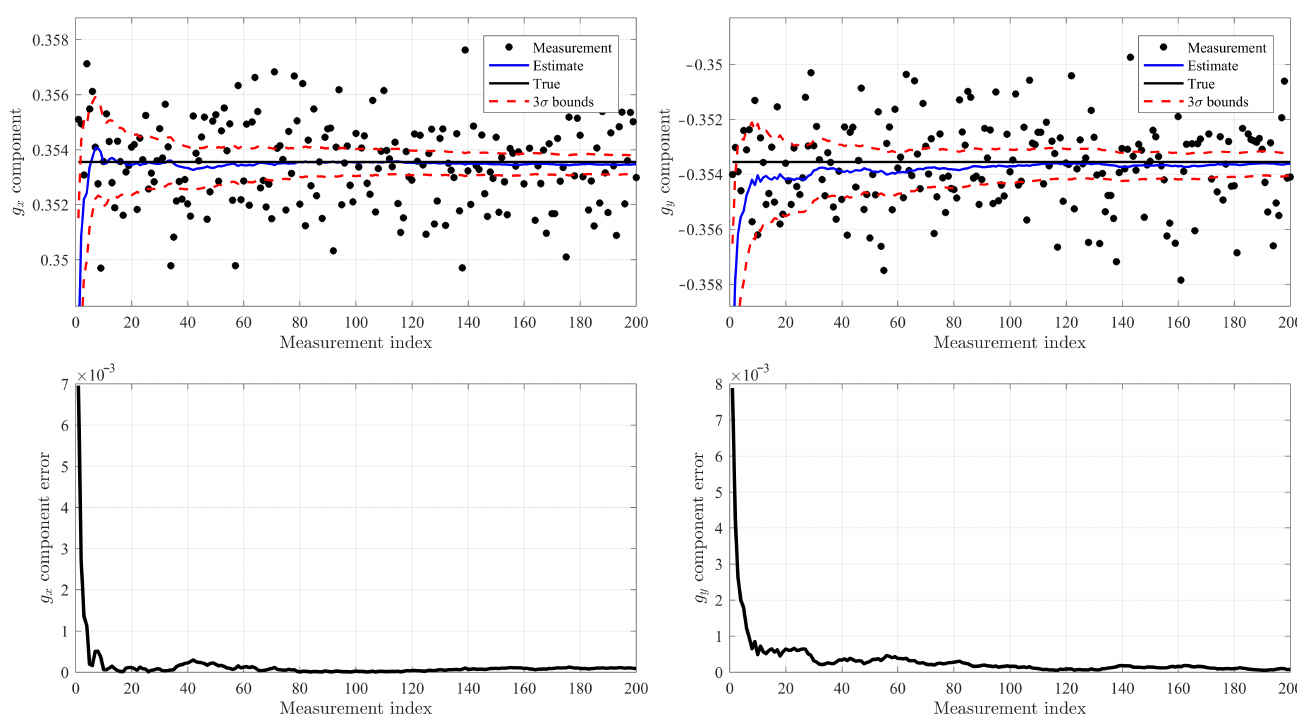
Figure 5. Extended Kalman Filter test